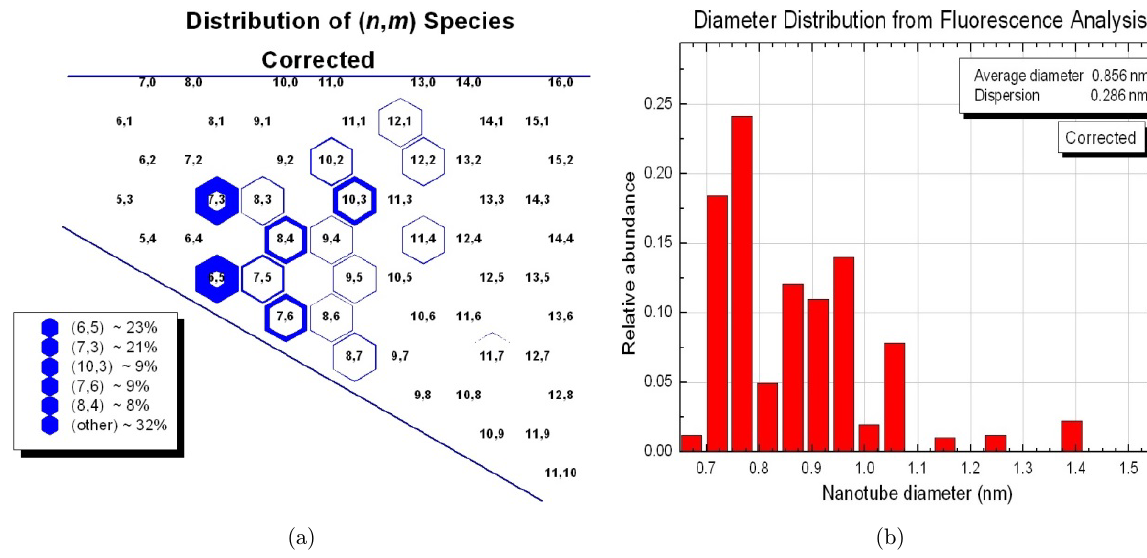
Fig. 1. Determination of chirality and diameter of SWNTS. Using a SWNT – GC solution (3 mg SWNTs and 7 mL 0.5% GC), one- dimensional emission spectra excited at 532, 636, 671, and 783 nm wavelengths were collected. The emission spectra were used to ¯t a model to a two-dimensional photoluminescence map (a) in order to estimate the semiconducting chirality composition and diameter distribution of the SWNT solution (b).